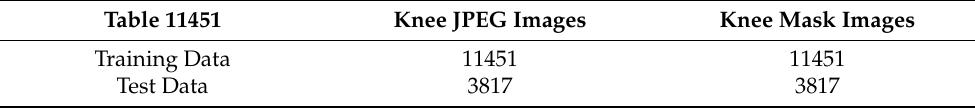
Table 3. The training and test split ratio of samples of knee MR images. Table